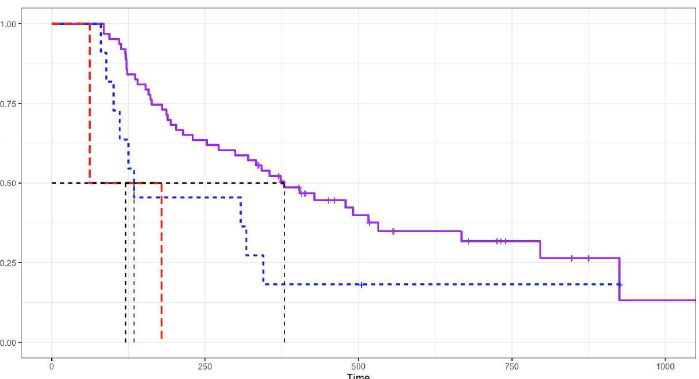
Figure 2. Log rank test analysis showing response to COP chemotherapy. Cats with complete response (MST 379 days; purple line) had significantly ( p = 0.008) longer survival times than those with partial response (MST 134 days; blue line) and no response (MST 121 days; red line). The median survival times based on sex, reproductive status, retroviral status, anatom- ical location, and blood transfusion after COP were not different, according to the log rank test analysis of the 76 cats. Cats aged <4 years (MST 373 days) had longer survival times than those aged at least 4 years (MST 212 days) ( p = 0.01). After the first induction of COP, cats that required thoracocentesis (MST 147 days) had shorter survival times ( p = 0.002) than those not requiring thoracocentesis (MST 373